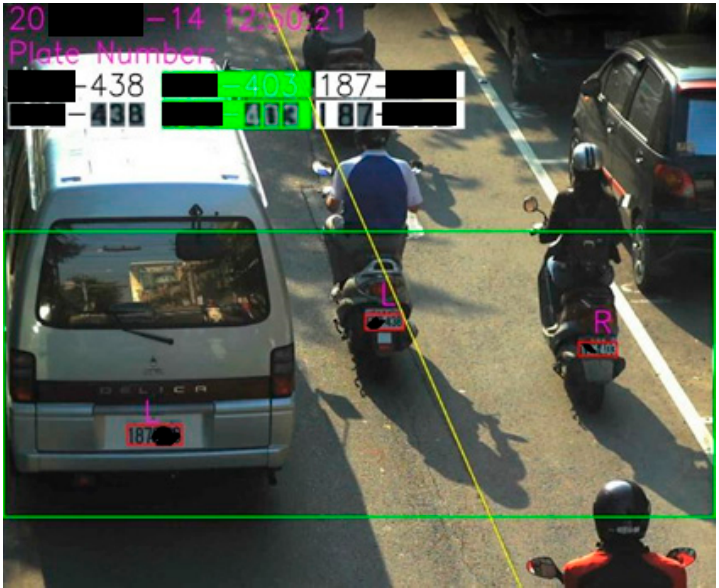
Figure 4. A schematic diagram for detecting the identification of daytime objects.